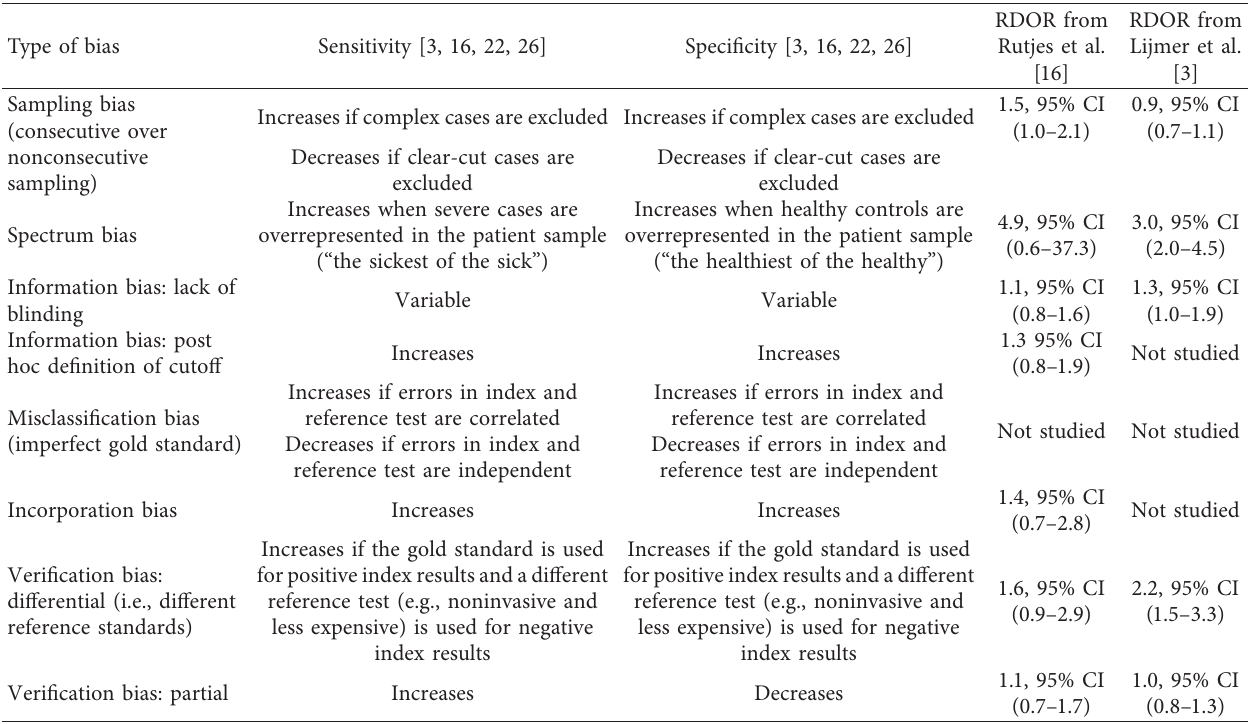
Table 3: Direction of diagnostic accuracy estimates by type of